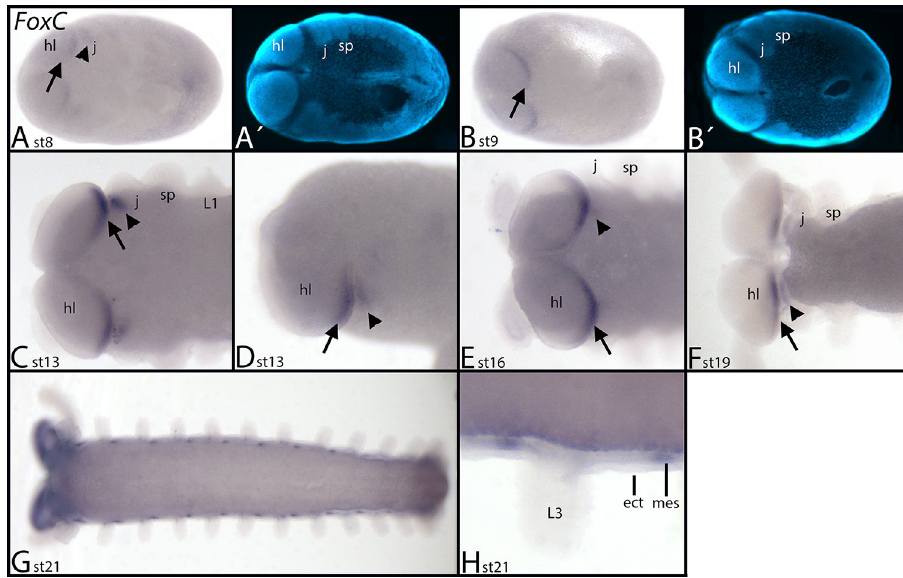
Fig 3. Expression of Euperipatoides FoxC . In all panels, anterior is to the left, ventral views, except panel D, lateral view, dorsal up. A´ and B´ represent DAPI staining of the embryos shown in A and B. In all panels, arrows point to expression at the posterior margin of the head lobes, and arrowheads indicate expression in the anterior of the jaw- bearing segment. Abbreviations in Table 2.